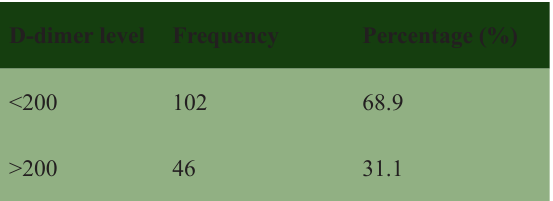
Table 2: Number of patients with normal and elevated D-dimer level D-dimer level Frequency